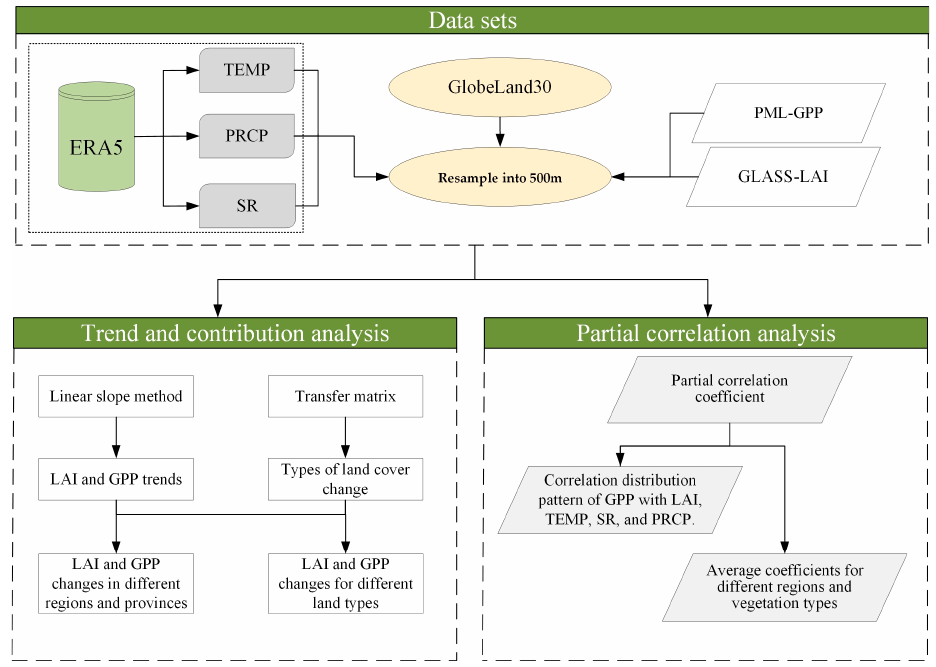
Figure 2. Overall flow scheme of this study.